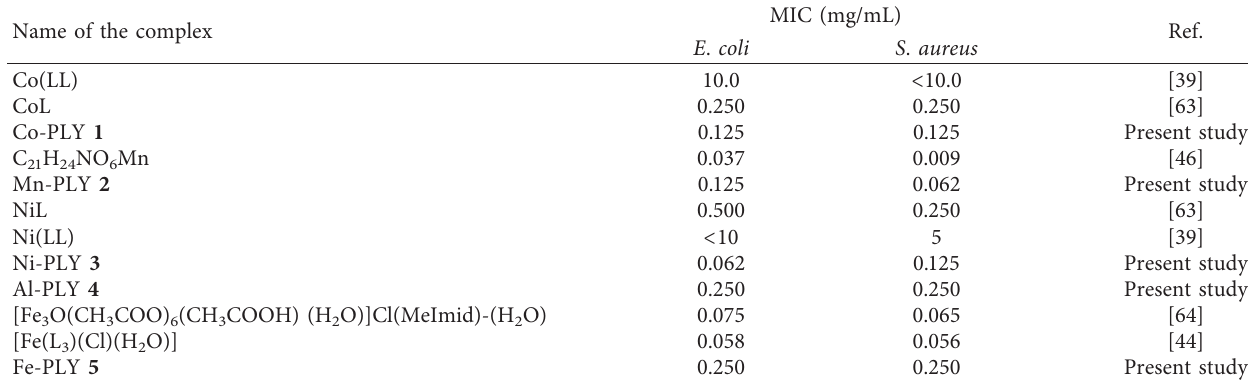
Figure 3: Graphical representation of the MIC values of the metal-PLY complexes (1 – 5) against E . coli and S . aureus. Table 4: MIC values of various metal complexes against E . coli and S .